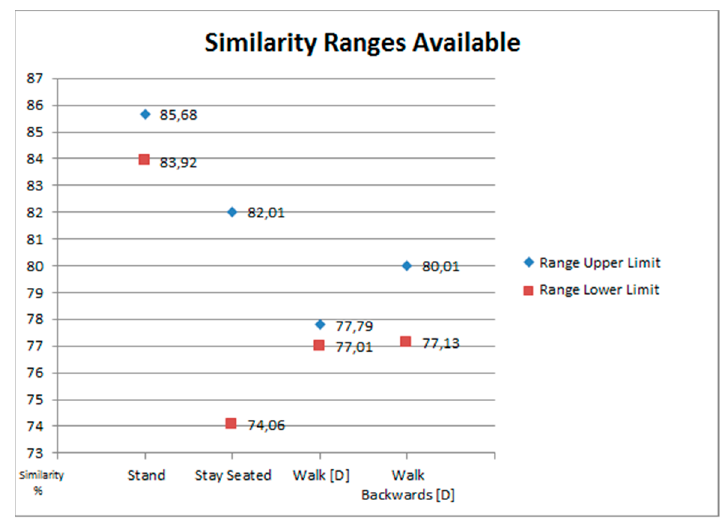
Figure 4. Available ranges of values for selecting minimum limits of prediction.